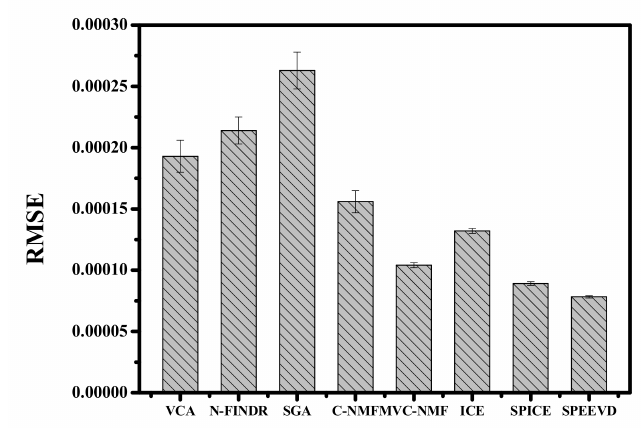
Figure 22. The RMSEs of the unmixing